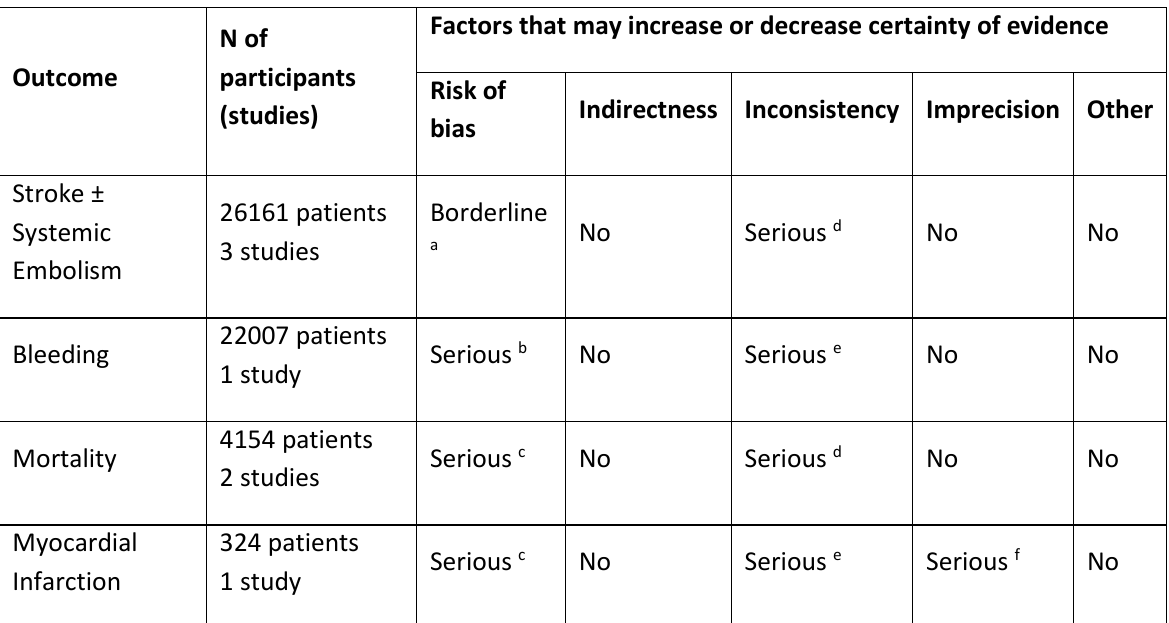
Supplemental table S3. Summary of GRADE